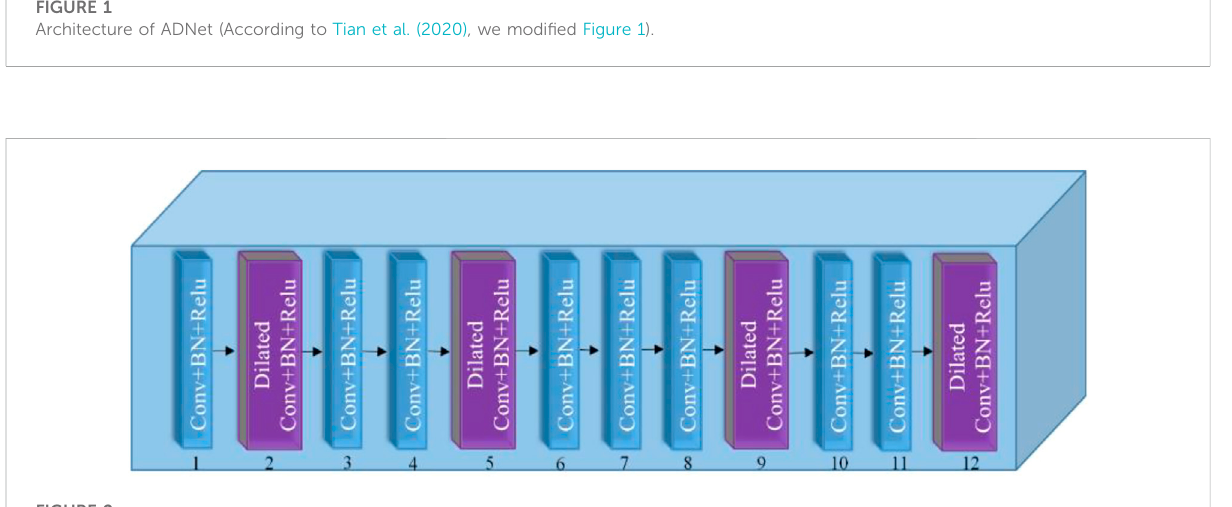
FIGURE 2 Architecture of the SB (According to Tian et al. (2020), we modi fi ed Figure 1).